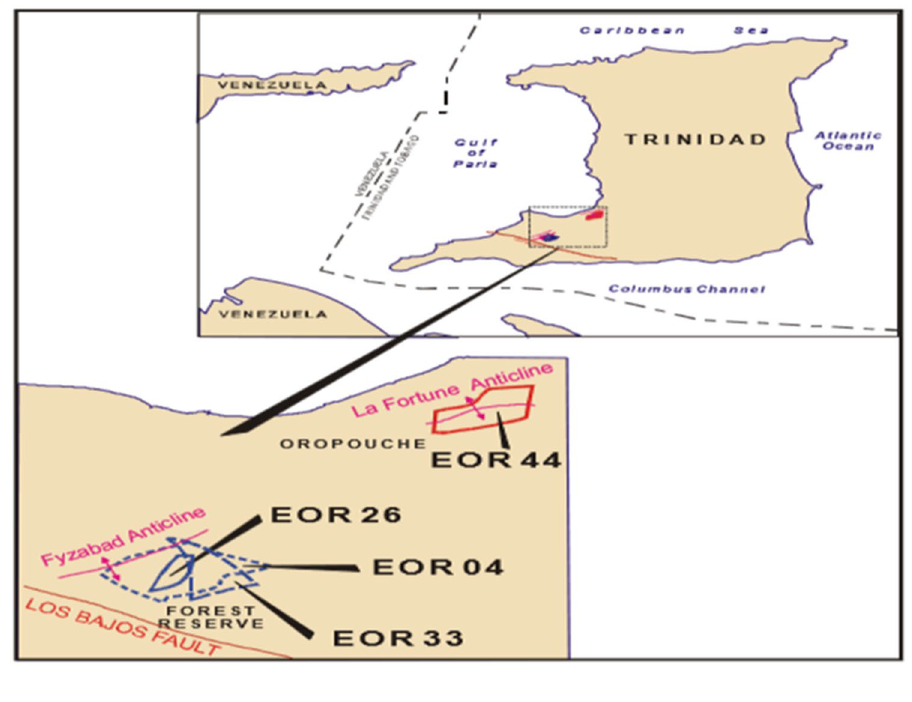
Fig. 3 Structure contour map AO-8 sands EOR 44 (Moham- mad-Singh and Singhal